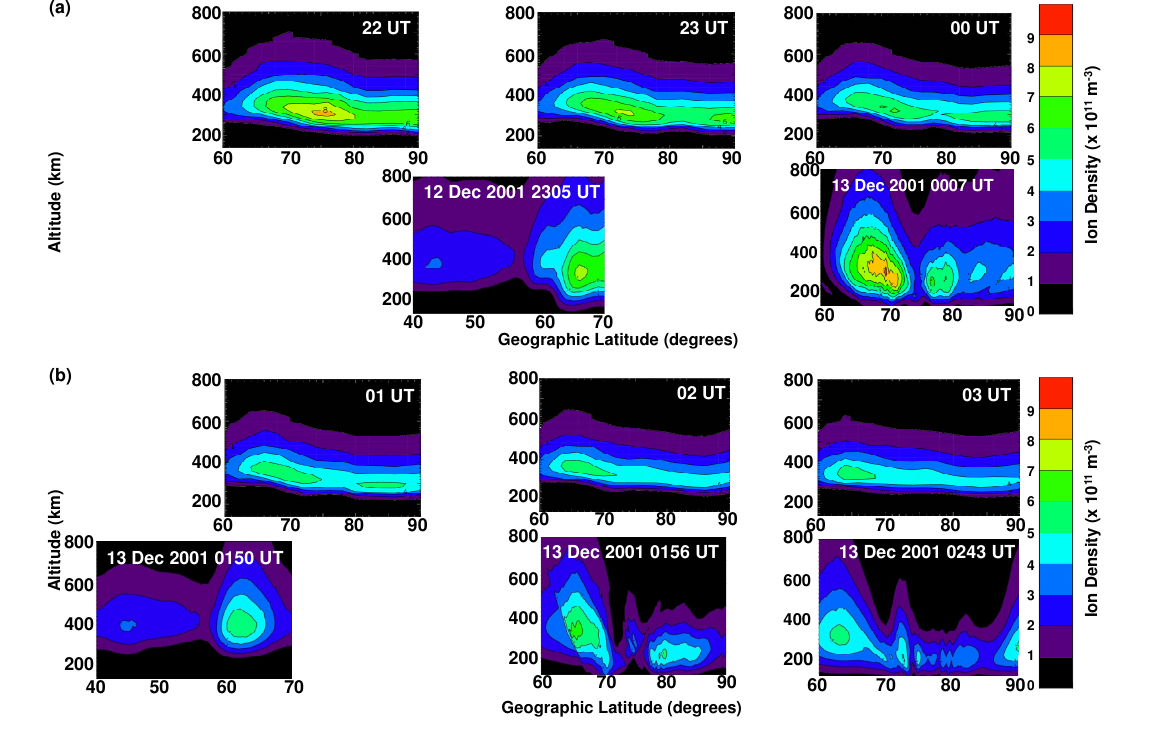
Fig. 6. Comparison of the CTIP modelled ion density (top row of each panel) and radiotomography observations (bottom row of each panel) on a latitude-versus-altitude grid. The modelled densities are at the 18 ◦ E meridian at hourly intervals between 22:00UT and 00:00UT in panel (a) and between 01:00UT and 03:00UT in panel (b) . These are paired with the corresponding tomography images in the bottom row of each panel. The reconstructions from the UK tomography chain are displaced to the left of those for the Scandinavian chain for consistency in the latitudinal placement of the observed ionisation